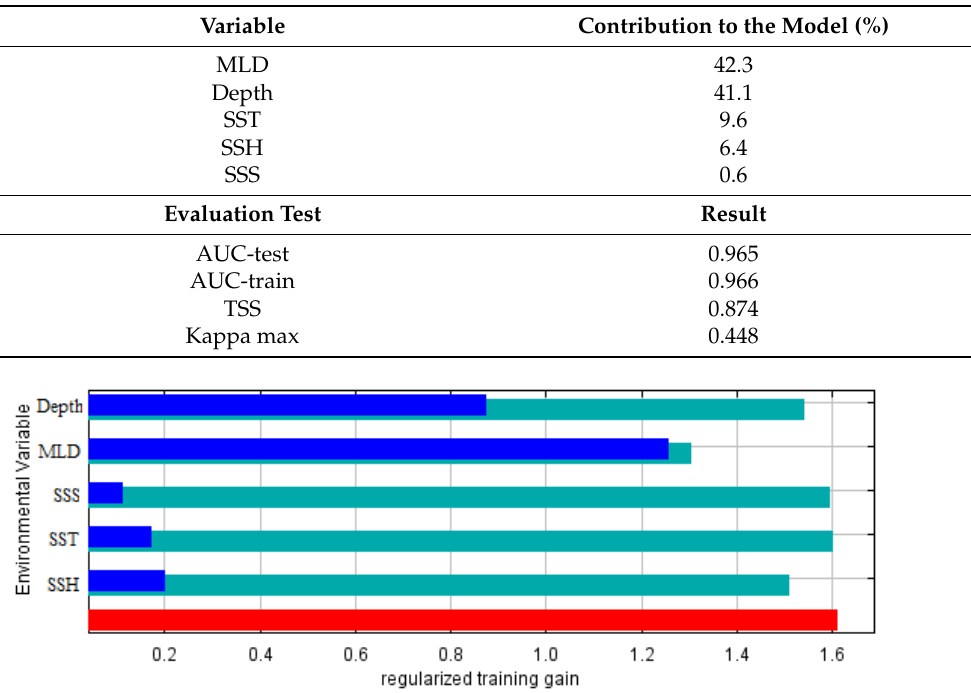
Table 1. Model evaluation and sensitivity tests and contribution percentage for each variable in the distribution model of Phalacrocorax nigrogularis . Variable Contribution to the Model (%)